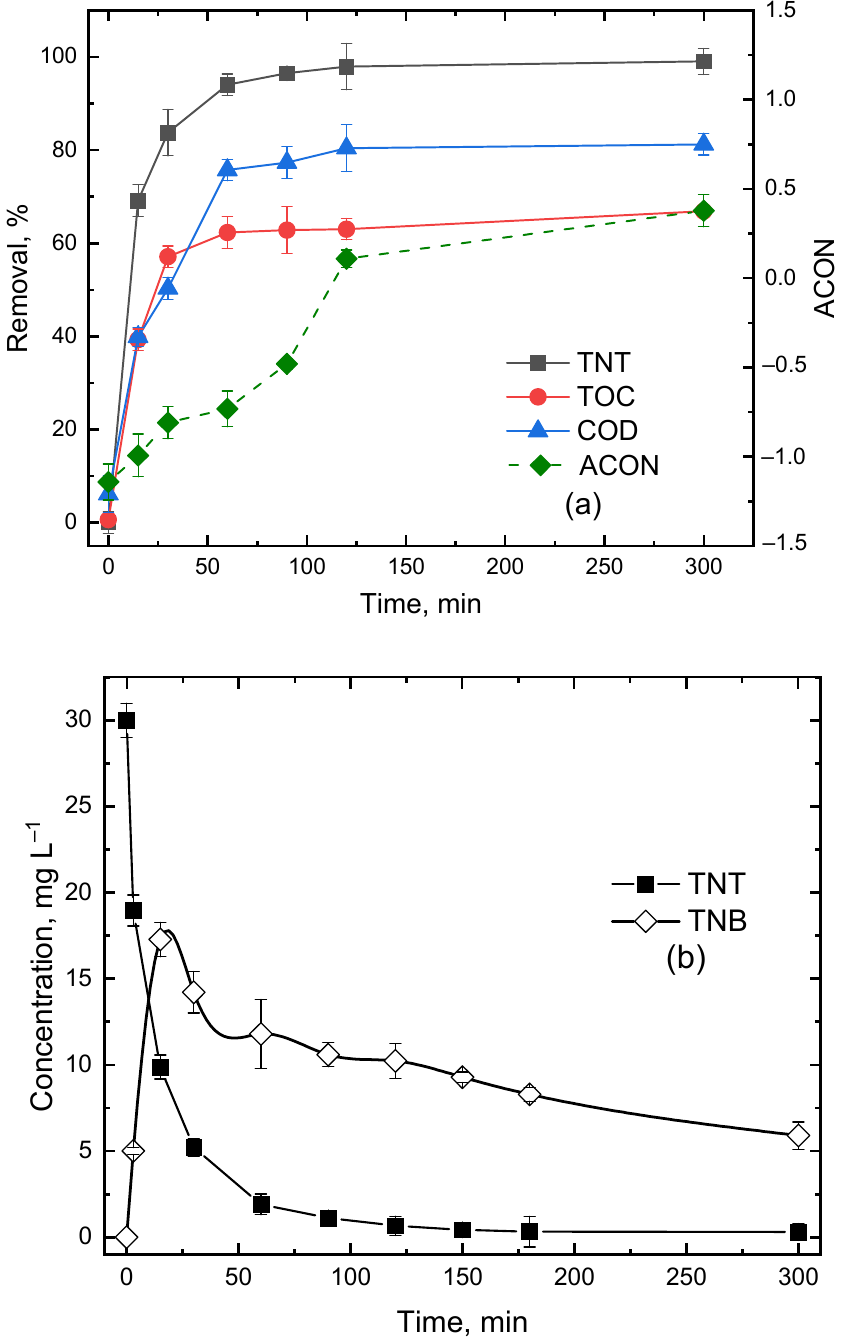
Figure 4. Effect of reaction time on the removal of TNT, TOC and COD ( a ) and change in TNT and TNB concentration as a function of time ( b ). Experimental conditions: (TNT) 0 = 30 mg/L, (Fe 2+ ) = 5 × 10 − 4 M, (H 2 O 2 ) = 5 × 10 − 3 M, (NaCl) = 10 − 2 M, Initial pH = 3.0 ± 0.1, US intensity = 8571 W/m 3 Temperature = 25 °C, Reaction time = 300 min.